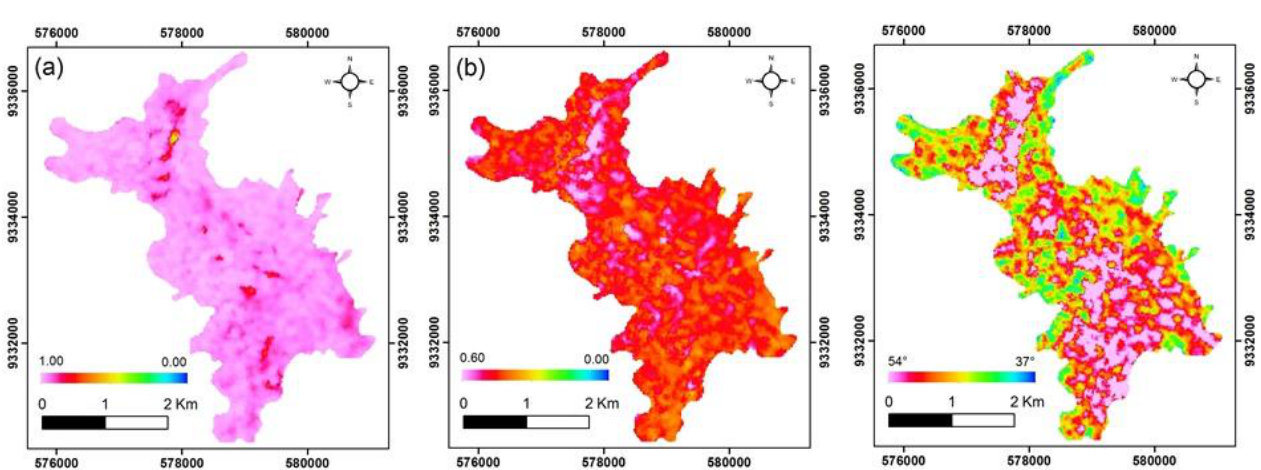
Figure 3. Images resulting from the parameters derived from the eigenvalue-eigenvector decomposition model for the R99B image: ( a ) entropy; ( b ) mean alpha angle; ( c )